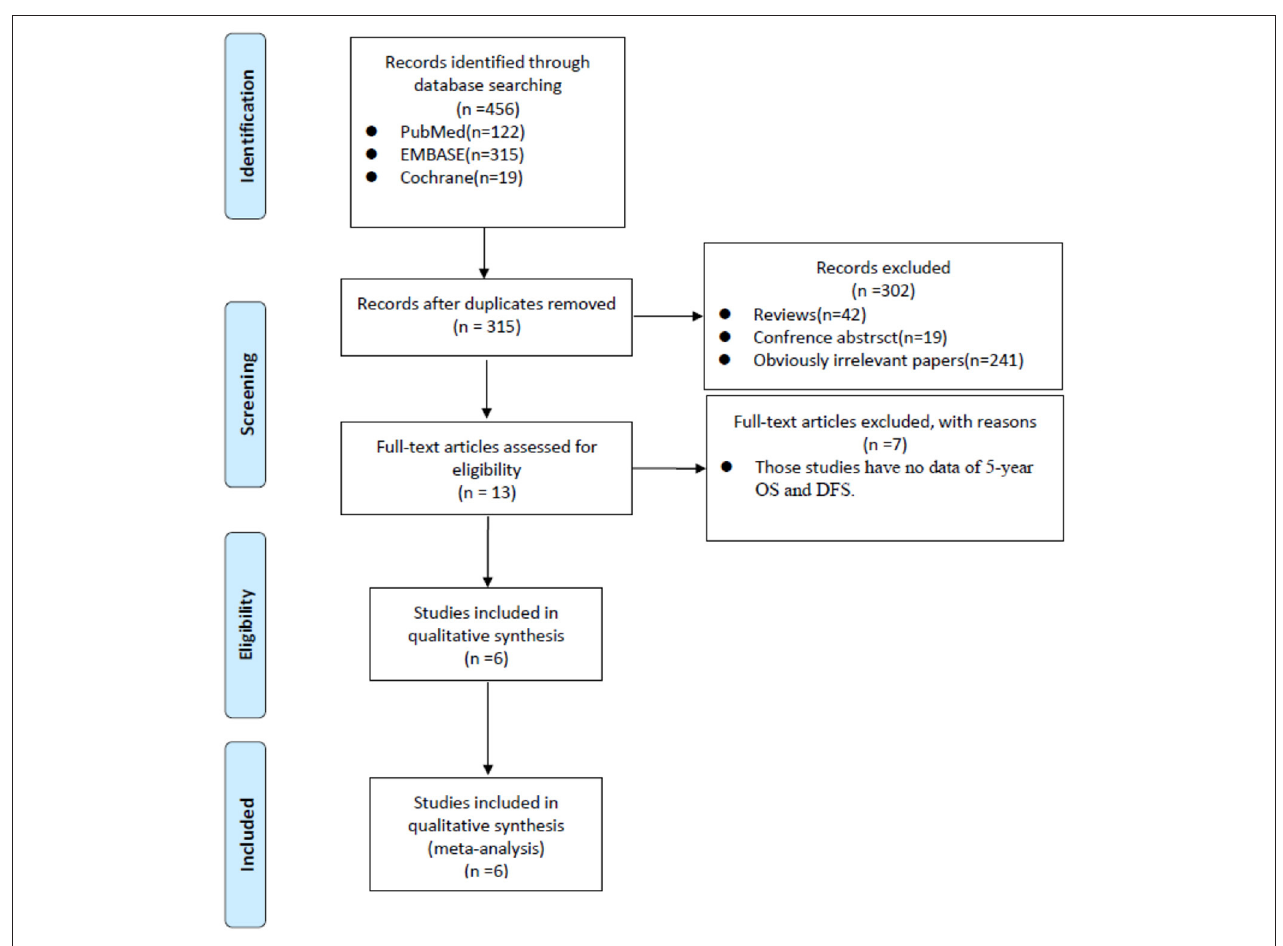
FIGURE 1 | PRISMA flow diagram showed the process of relevant studies evaluation. PRISMA, Preferred Reporting Items for Systematic Reviews and Meta-analysis; OS, overall survival; DFS, disease-free survival.